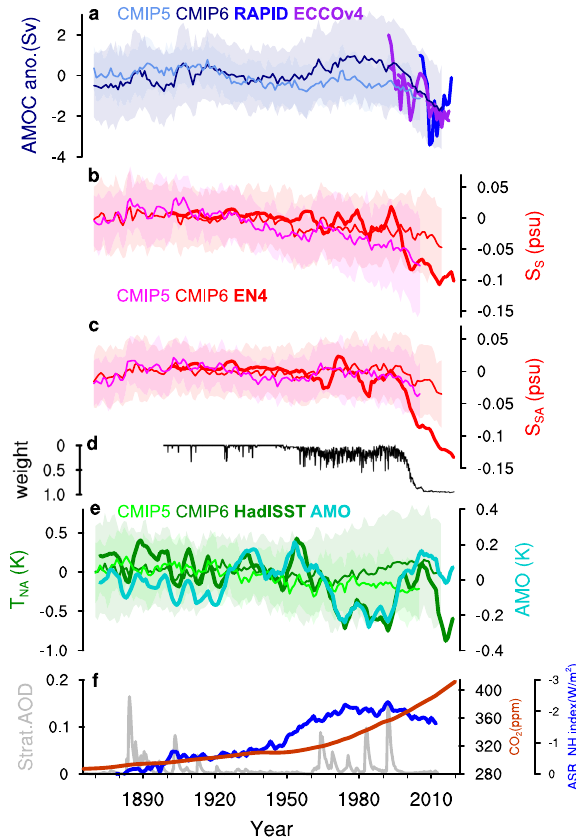
Fig. 1 | Data-model comparison. Time series of observed (thick lines) and multi- model ensemble mean (MMEM, thin lines; shading shows one standard deviation) ( a ) anomaly of Atlantic meridional overturning circulation (AMOC) intensity, ( b ) the salinity pileup fi ngerprint S S , ( c ) the salinity pileup fi ngerprint S SA , ( d ) monthly mean observation weight of salinity analysis over the subtropical South Atlantic (analysis value is more in fl uenced by observations with weight closer to one), ( e ) theclassicalwarminghole fi ngerprintT NA and( f )keyexternalforcingofCO 2 (from NASA GISS, brown), anthropogenic (ASR_NH, blue, Methods) and volcanic (shown as global stratospheric aerosol optical depths at 550nm; from NASA GISS, grey) aerosols. Observed fi ngerprints (EN4 analysis data for S S and S SA ; HadISST dataset for T NA ) are shown as 5-year running means. The AMOC anomaly from ECCOv4r4 reanalysisandRAPIDmeasurementsareshowninthickpurpleandbluelineswith1 and 2 offsets, respectively. The linear change of ECCOv4r4 AMOC is plotted in dashedpurpleline.Alsoshownin( d )istheobservedAMOindex(Methods).Model results are relative to the means of 1900 –